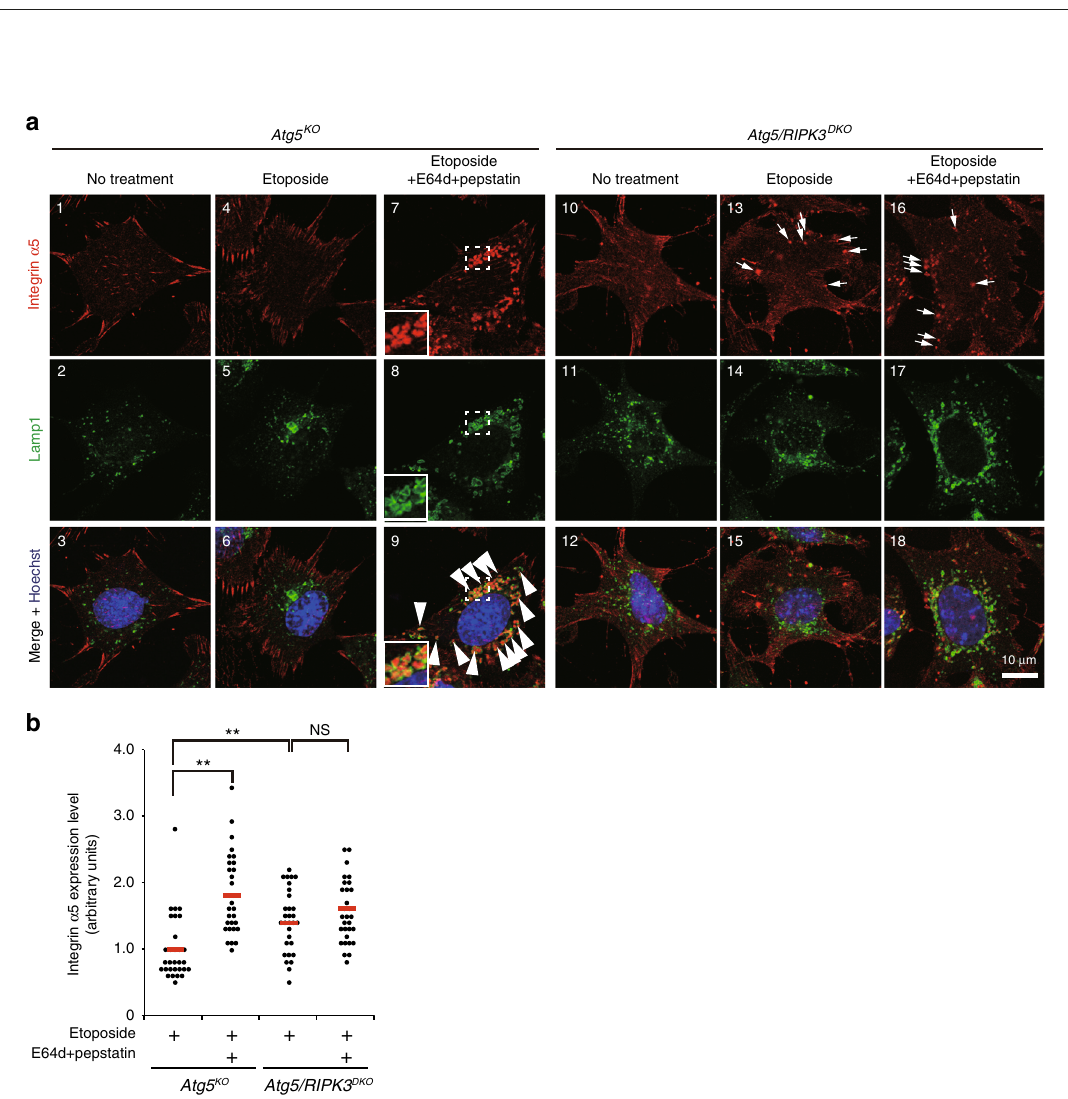
Fig. 9 Effect of RIPK3 on the degradation of undelivered VSVG upon etoposide treatment. a Schematic diagram of the experiment. The VSVG – GFP was expressed in Atg5 KO MEFs and Atg5/RIPK3 DKO MEFs, and the cells were treated with or without etoposide (10 µ M) at the restrictive temperature (40 °C) for 12 h. Cells were then shifted to the permissive temperature (32 °C), and fi xed at the indicate times. Golgi was counterstained with an anti-GS28 antibody. b Representative images are shown. At 0, 15, and 60 min after the temperature shift, the location of VSVG – GFP and Golgi were analyzed. c Reduction of PM-localized VSVG – GFP upon etoposide treatment. VSVG – GFP-expressing Atg5 KO MEFs were or were not treated with etoposide, and at 60 min after the temperature shift, cells were stained with an anti-VSVG antibody for 30 min at 4 °C followed by the addition of an Alexa Fluor 633- conjugated secondary antibody for 30 min at 4 °C. After washing the cells, the amount of PM-localized VSVG – GFP was measured using fl ow cytometry. d , e VSVG – GFP-expressing Atg5 KO MEFs and Atg5/RIPK3 DKO MEFs were treated with etoposide (10 µ M) in the presence of E64d/pepstatin. At 60 min after the temperature shift, cells were immunostained with an anti-Lamp2 antibody. In d , representative images are shown. Arrowheads indicate autolysosomes containing VSVG – GFP. A magni fi ed image of the areas within the dashed squares is shown in the insets. In e , the amount of total VSVG – GFP (the level of fl uorescence intensity in each cell) was measured using Image J ( n = 30 cells in each experiment). Red bars indicate mean values. Atg5 KO Etoposide vs. Etoposide with E64d/pepstatin: p = 0.0043, Atg5/RIPK3 DKO Etoposide vs. Etoposide with E64d/pepstatin: p = 0.6495. Comparisons were performed using one-way ANOVA followed by the Tukey post-hoc test. ** p < 0.01; NS: not signi fi cant. Source data are provided as a Source Data fi le.